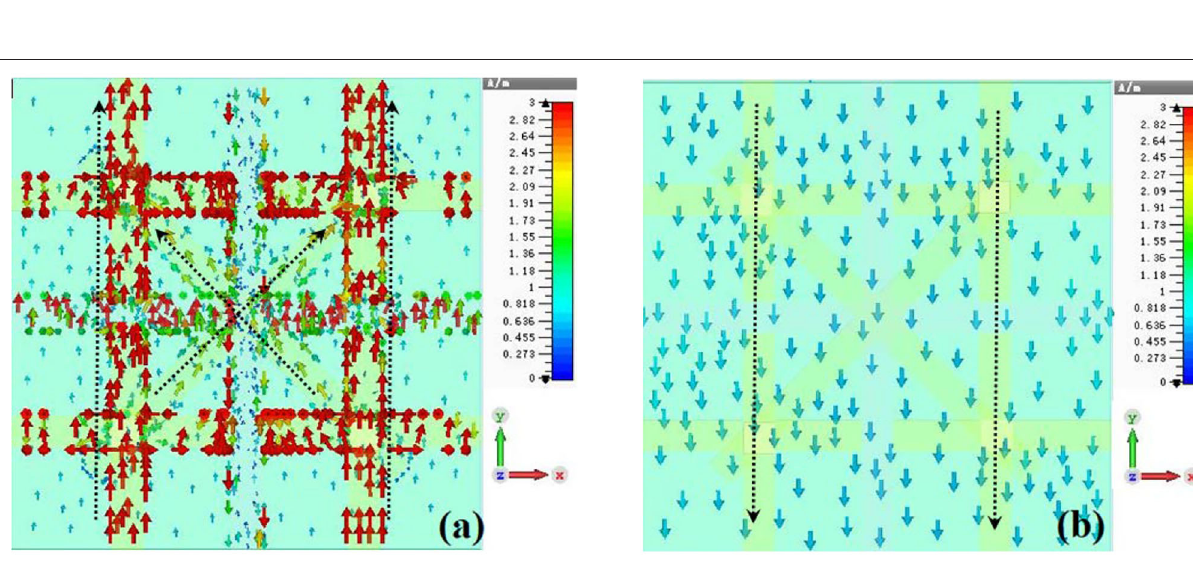
FIGURE 6 | (a,b) The surface current distribution of the metamaterial absorber at 6 GHz with the Fermi level of graphene at